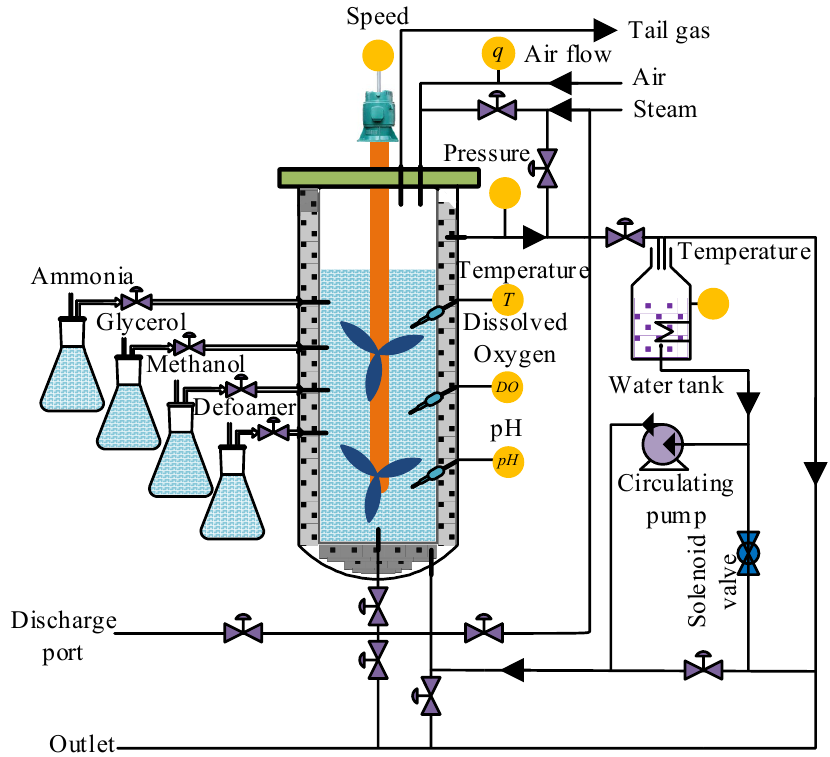
Figure 5. Schematic diagram of Pichia pastoris fermentation process.